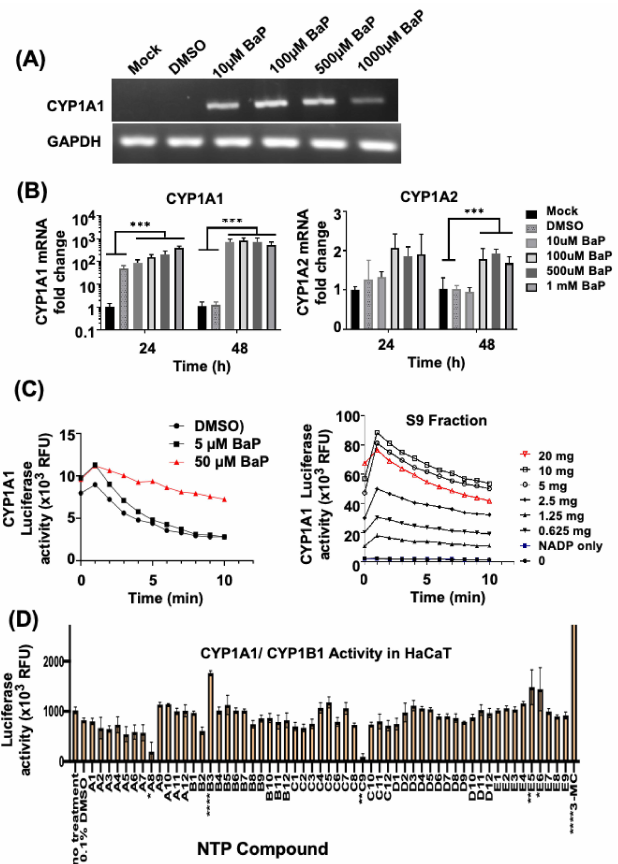
Figure 7. CYP activity in HaCaT keratinocytes after chemical treatment. Upregulation of CYP1A and CYP1A2 mRNA in HaCaT keratinocytes treated with Benzo[a]pyrene. ( A ) RNA (1 µ g) was extracted at the indicated time points and subjected to reverse transcription to obtain cDNA, followed by RT-PCR, as well as ( B ) qPCR (SYBR Green) to detect CYP450 mRNA expression levels for CYP1A1 and CYP1A2. GAPDH served as an internal control. ( C ) CYP450 luciferase activity assay of human keratinocytes from EpiDerm samples treated with indicated doses of Benzopyrene (BaP) (left panel) and liver S9 fraction (right panel). Serial two-fold dilution of human S9 fraction was incubated with analog substrate (luciferin-CEE), and then the luciferase kinetic assay was performed and plotted (reading every 1 min). ( D ) CYP450 luciferase activity assay of HaCaT cells treated with each of the NTP compounds indicated. Data were collated from biological replicates. *, **, ***, and **** represent p values < 0.05, 0.01, 0.001, and 0.0001